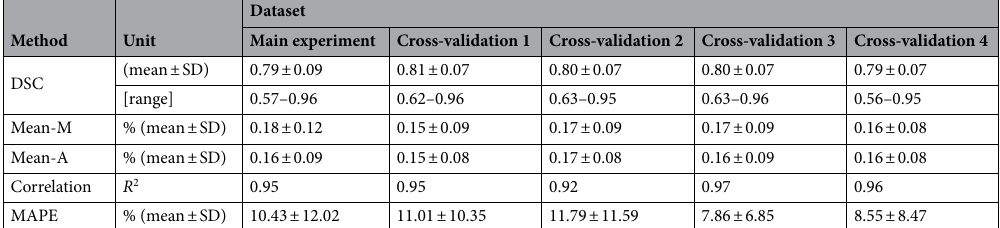
Table 3. Cross-validation results for submandibular %ID. DSC dice similarity coefficient, M manual segmentation, A automatic segmentation, MAPE mean absolute percentage